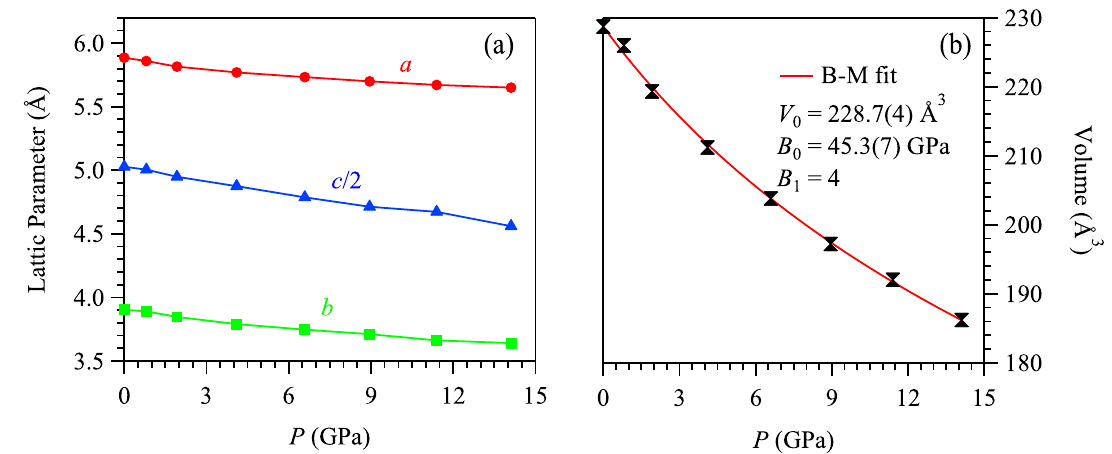
Fig. 7 Crystal-structural under high pressure. Pressure dependences of a the lattice parameters and b volume of HfTe 3 at room temperature. The solid line in ( b ) represents the fi t with the Birch – Murnaghan (B – M) equation of state to extract the bulk modulus B 0 as given in the fi gure.